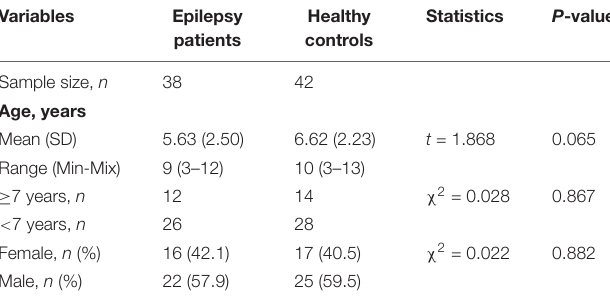
TABLE 1 | Characteristics of study